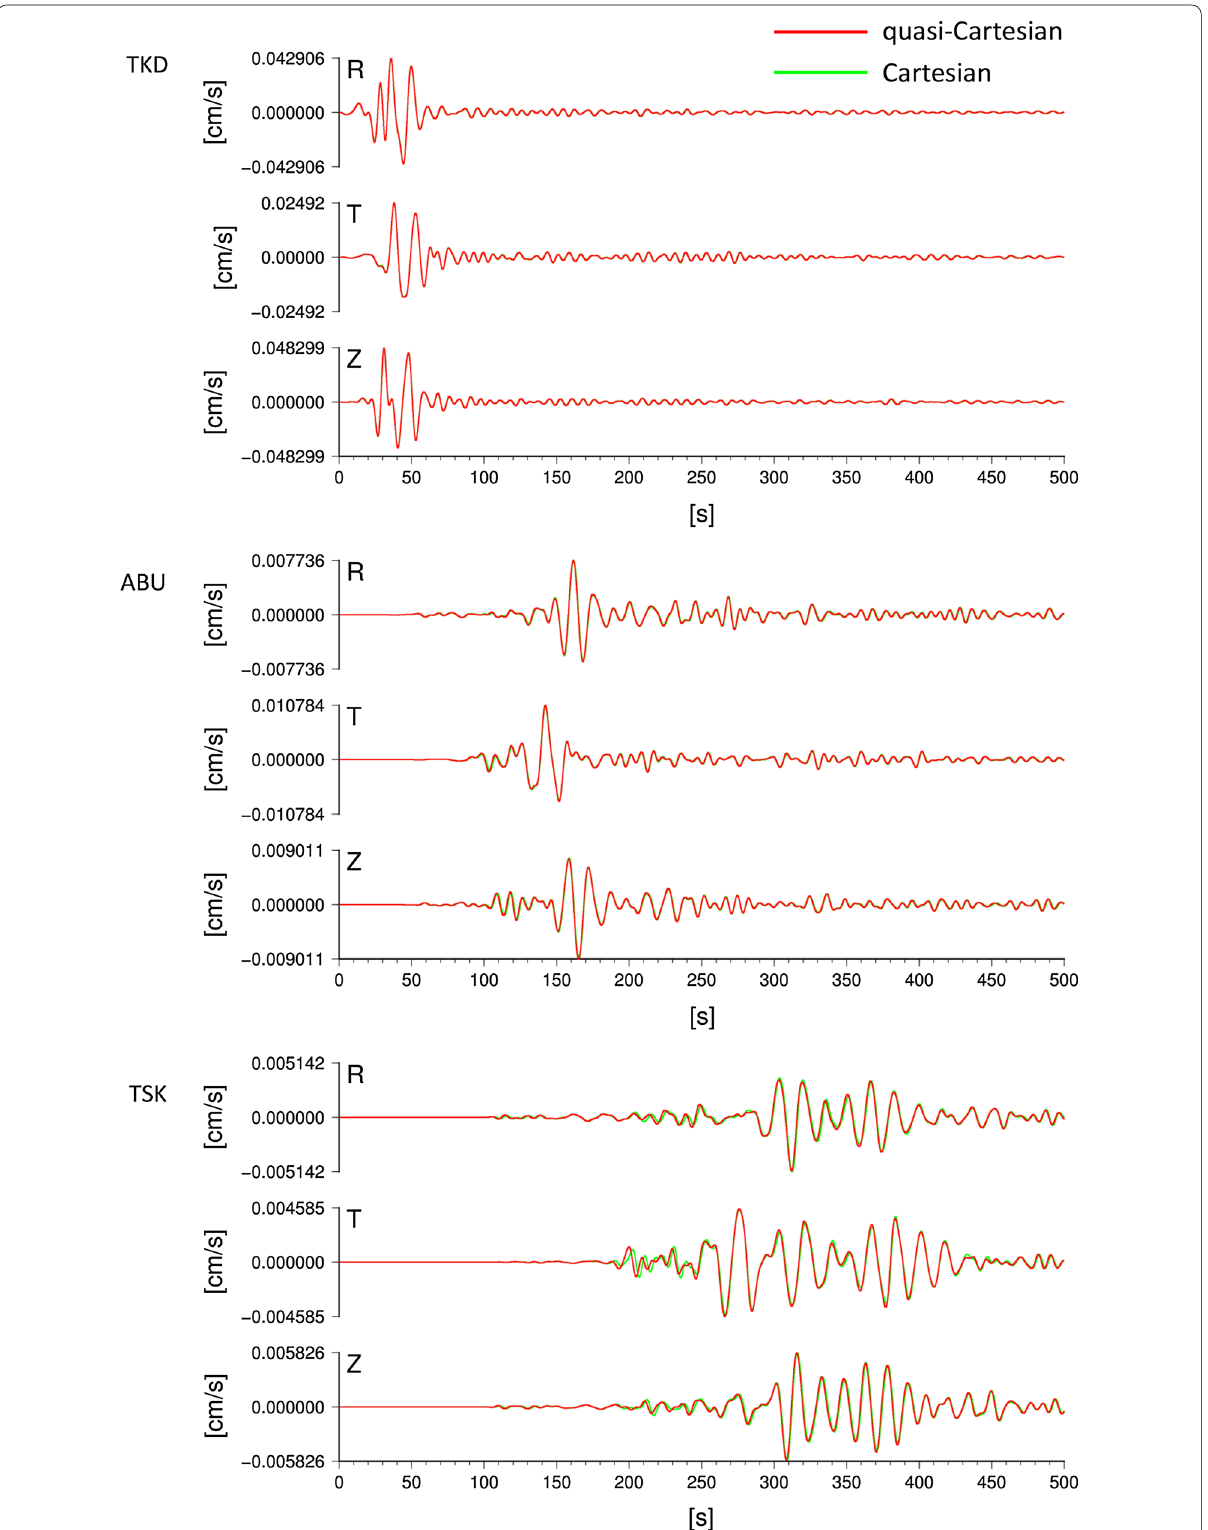
Fig. 10 Comparison between synthetic waveforms by the quasi-Cartesian ( red ) and the Cartesian ( green ) FDTDs at three stations marked in the right panel of Fig.